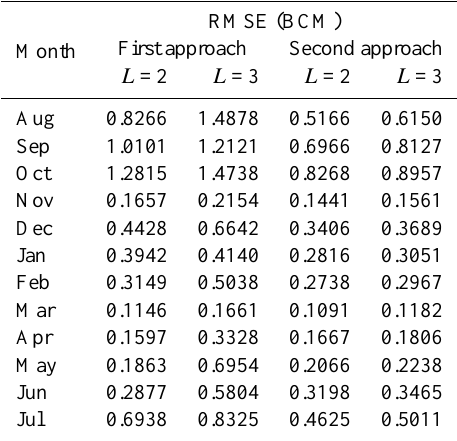
Table 5. RMSE associated with Ensemble ANN forecasting model for the period 1961–2000.